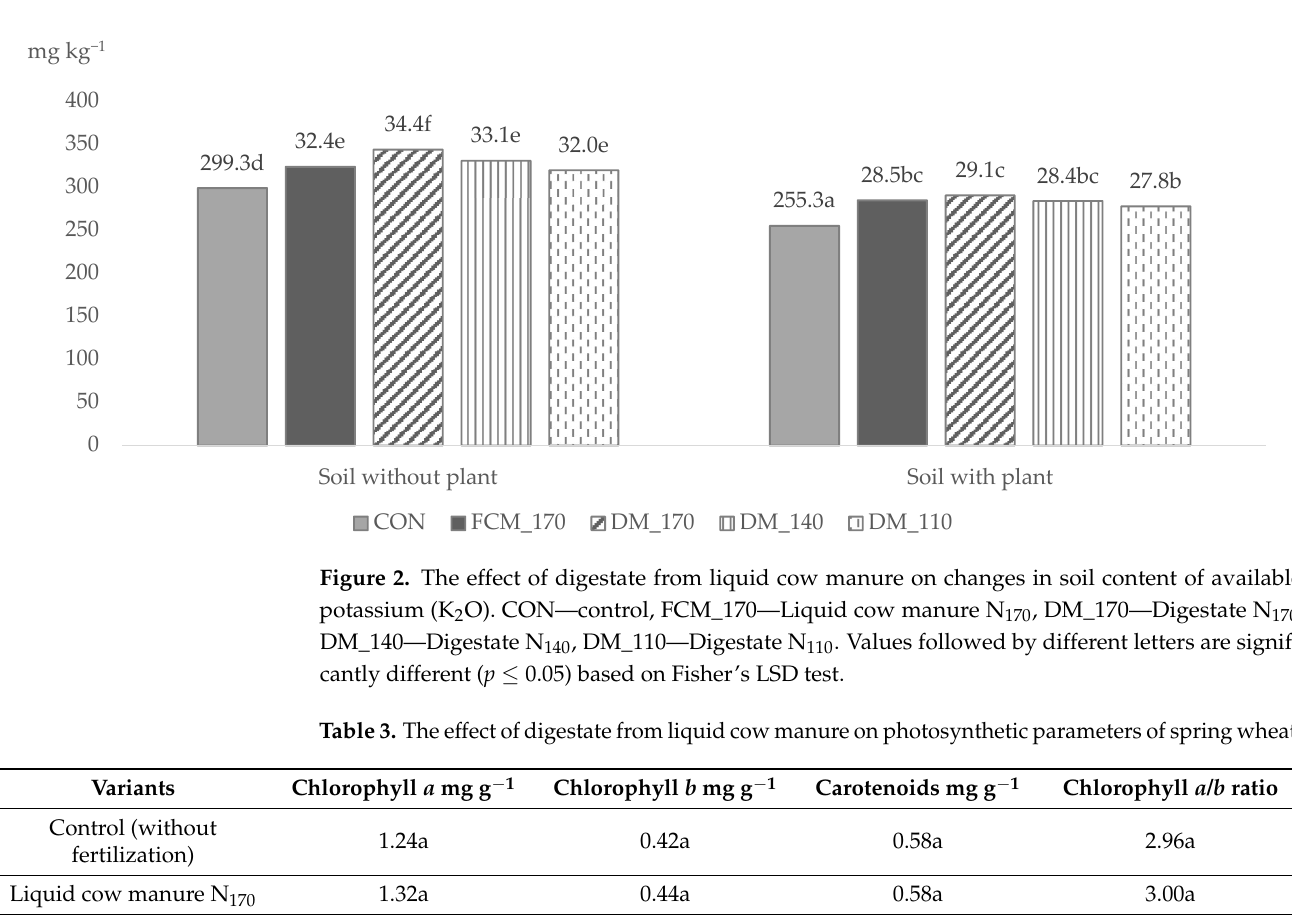
Table 3. The effect of digestate from liquid cow manure on photosynthetic parameters of spring wheat.